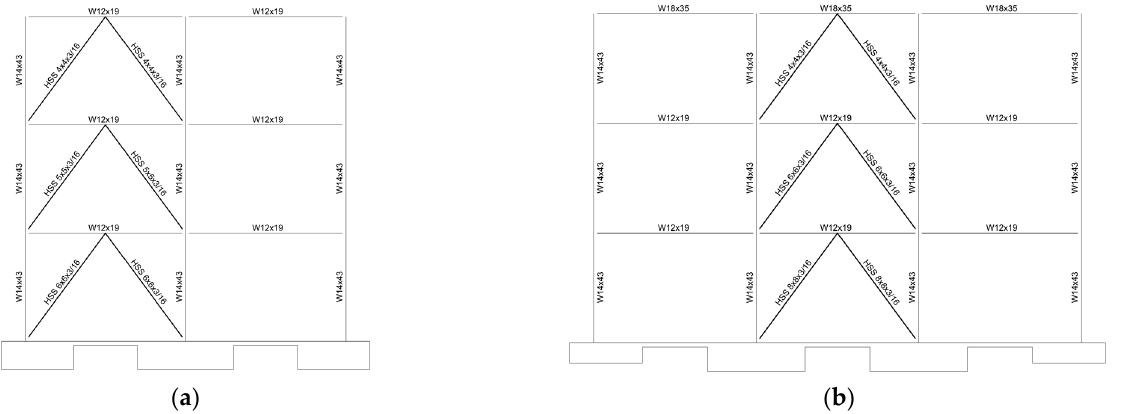
Figure 2. LFRS of test structure: ( a ) Braces along gridlines B and C, looking east (typical); ( b ) Braces along gridline 2, looking north.